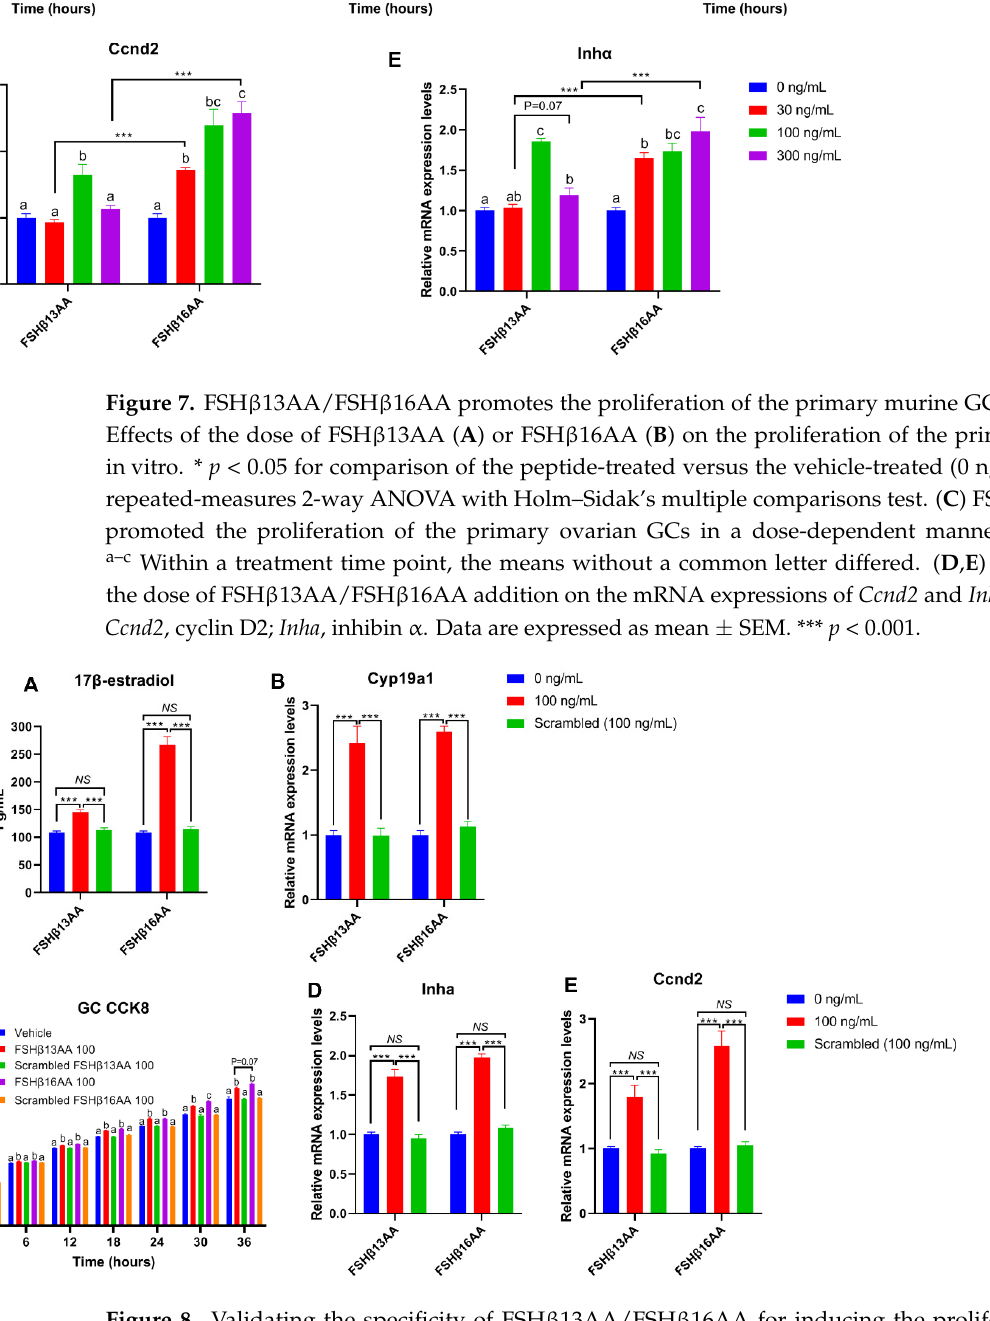
Figure 8. Validating the specificity of FSH β 13AA/FSH β 16AA for inducing the proliferation of primary GCs and estrogen production in vitro. ( A , B ) Effects of FSH β 13AA/FSH β 16AA versus their scrambled peptide control (dose = 100 ng/mL) on the 17 β‐ estradiol production ( A ) and the mRNA expressions of Cyp19a1 ( B ) in the cultured primary ovarian granular cells (GCs). ( C – E ) Effects of FSH β 13AA/FSH β 16AA versus their scrambled peptide control on the primary ovarian GCs prolif ‐ eration ( C ), mRNA expression of Inha ( D ) and Ccnd2 ( E ). Primary ovarian granular cells were isolated from the mice on day 25. Details regarding the scrambled peptides for FSH β 13AA/FSH β 16AA are shown in Supplementary Table S1. Data are expressed as mean ± SEM. Cyp19a1 , cytochrome P450, family 19, subfamily A, member 1 (aromatase), Ccnd2 , cyclin D2; Inha , inhibin α . *** p < 0.001; NS, not significant ( p > 0.05); a–c Within an interval, the means without a common letter differed. 2.4. FSH β 13AA/FSH β 16AA Antagonized Endogenous FSH Actions in the Adult Female Mice During each estrus cycle in mice, along with a rise in the circulating FSH concentra ‐ tions during proestrus, the FSH increases both the estrogen production and the uterus weight, with both peaking during proestrus [24]. Compared to the vehicle ‐ injected con ‐ trol, a single FSH β 13AA or FSH β 16AA treatment during diestrus mitigated the proestrus ‐ associated increases ( p < 0.05) in the ovary weight and uterus weight, and in the serum 17 β‐ estradiol concentrations (Figure 9A–C), with no differences between the FSH β 13AA ‐ and FSH β 16AA ‐ injected females ( p > 0.05; Figure 9A–C). Furthermore, based on qPCR, either FSH β 13AA or FSH β 16AA during diestrus down ‐ regulated the mRNA expressions of the estrogen biosynthesis ‐ associated genes, including Lhcgr , Star , Hsd3 β 1 and Cyp17a1 in the ovaries during proestrus. Excepting these genes, FSH β 16AA also markedly down ‐ regulated ( p < 0.05; Figure 9D) the mRNA expressions of the estrogen biosynthesis ‐ asso ‐ ciated genes Cyp11a1 and Cyp19a1 , and the follicle development ‐ associated gene Cdh1 in the ovaries. However, these genes only tended ( p < 0.1) to be downregulated in the FSH β 13AA ‐ injected females, indicating a greater potency of FSH β 16AA than FSH β 13AA for antagonizing the endogenous FSH actions. Finally, FSH β 16AA during diestrus selec ‐ tively upregulated ( p < 0.05) the Amh expressions in the ovaries during proestrus.